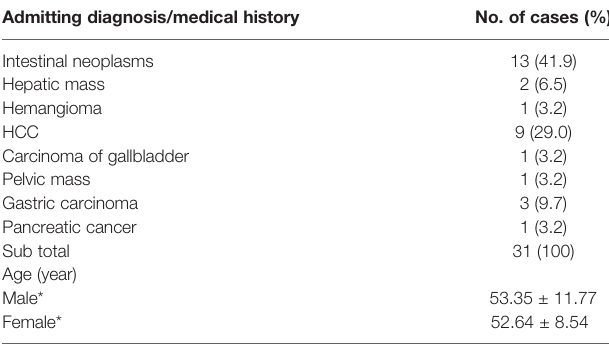
TABLE 1 | Clinical characteristics of the